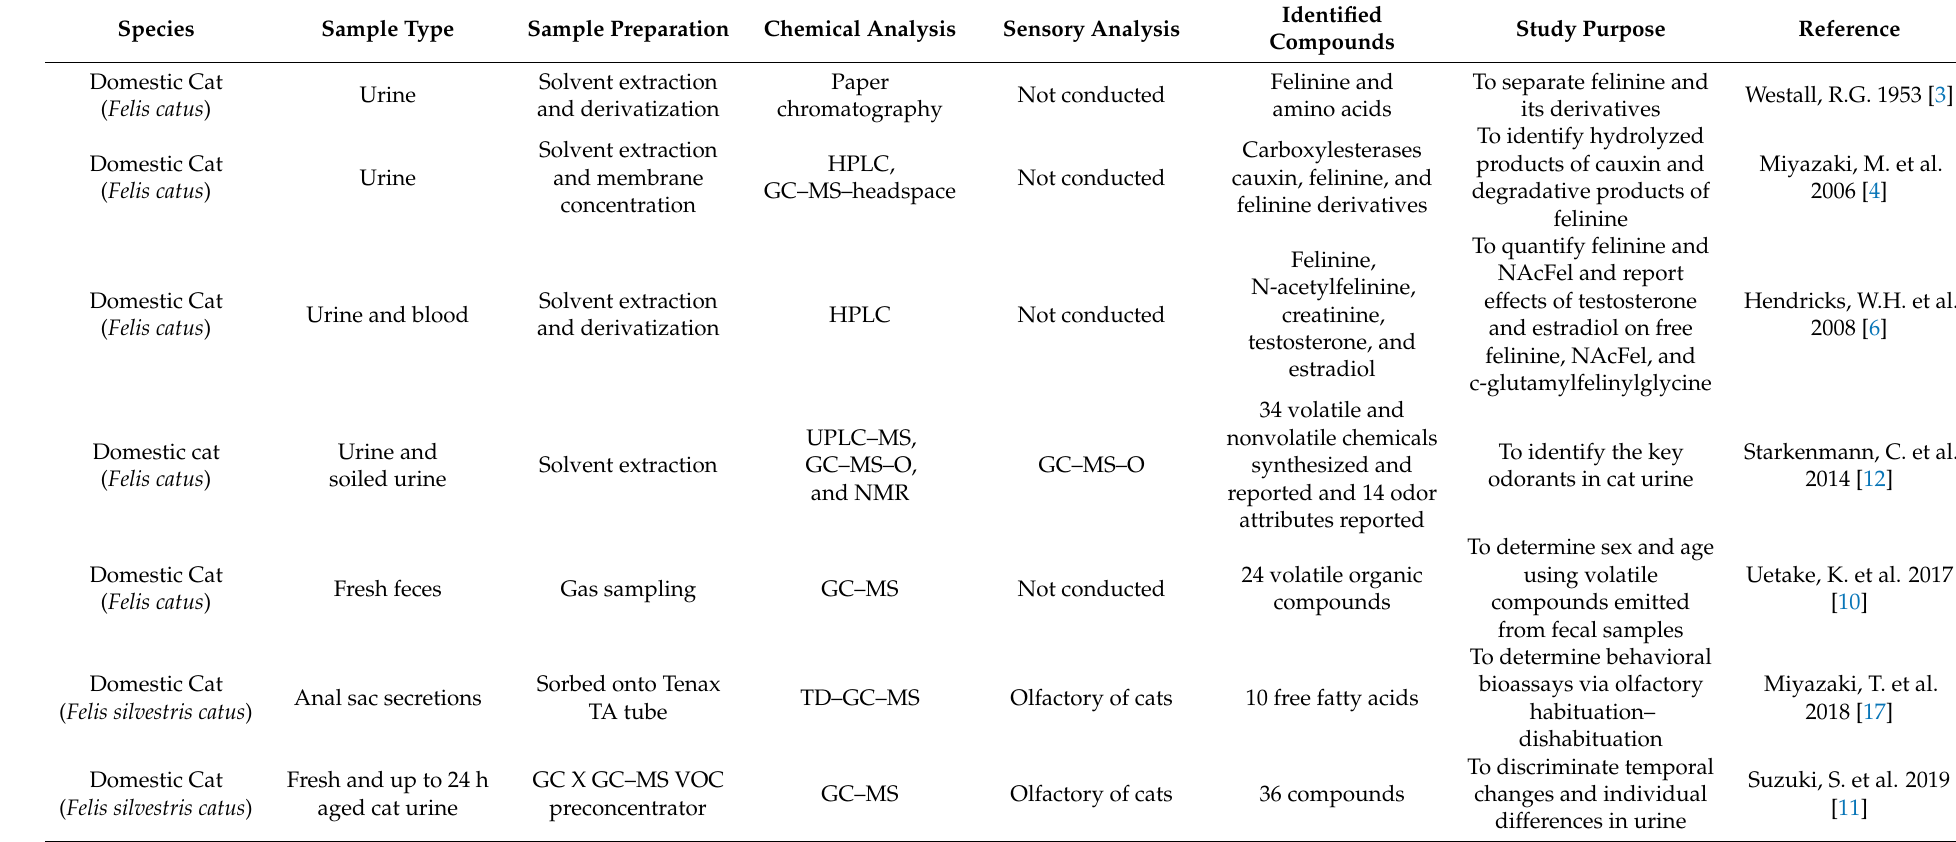
Table 1. Literature related to domestic cat urine and feces sample preparation for chemical and sensory analysis to identify and compare the chemical constituents of cat